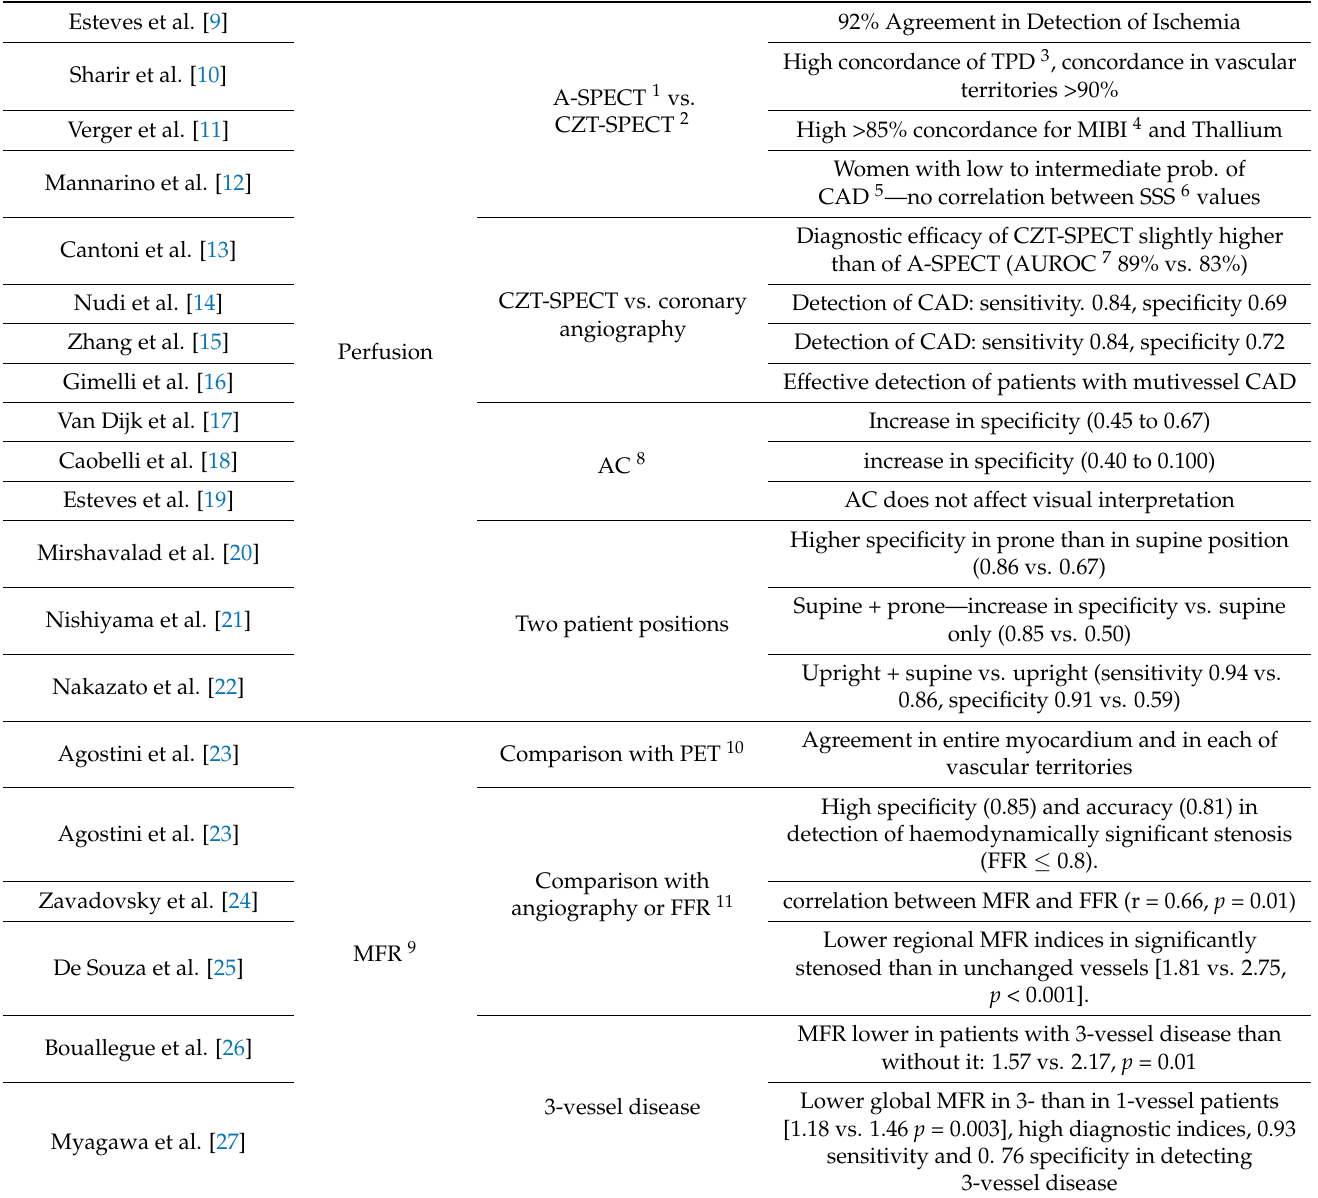
Table 1. The most important information along with a list of literature on the clinical use of CZT cameras in the diagnosis of coronary artery